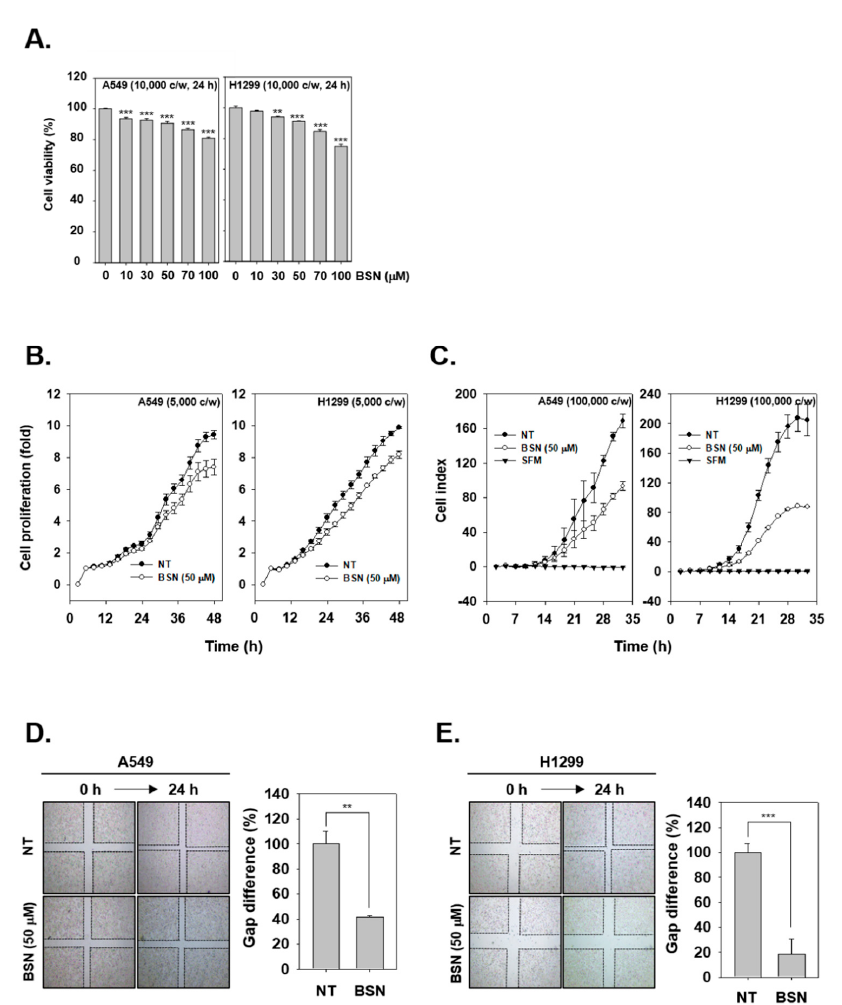
Figure 3. BSN represses various hallmarks of tumor cells. ( A ) A549 and H1299 cells (1 × 10 4 cells / well) were treated with various doses of BSN and viability was examined. ( B ) BSN reduces the growth of tumor cells. ( C ) Invasive ability of cells was measured upon BSN treatment. ( D , E ) Anti-migratory potential was analyzed after exposure to BSN (50 µ M) for 24 h. Data represent means ± SD; ** p < 0.01, *** p <